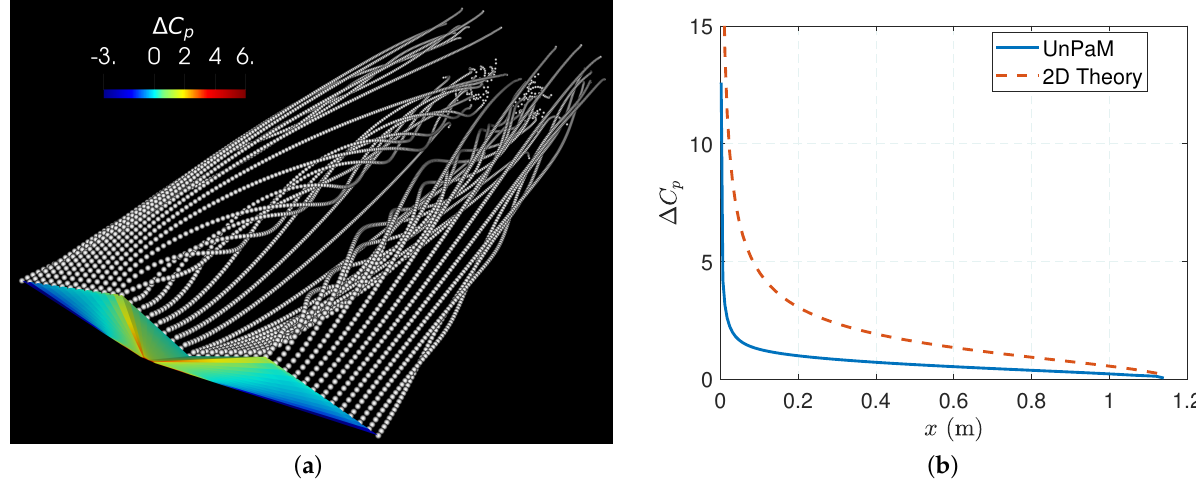
Figure 8. UnPaM aerodynamic simulation (20th time step) at a fixed α of 20º and β of 0º. ( a ) shows the ∆ C p across the kite and the wake roll-up while ( b ) shows the central spine ∆ C p distribution for the 3D case (UnPaM) and 2D theory of a flat